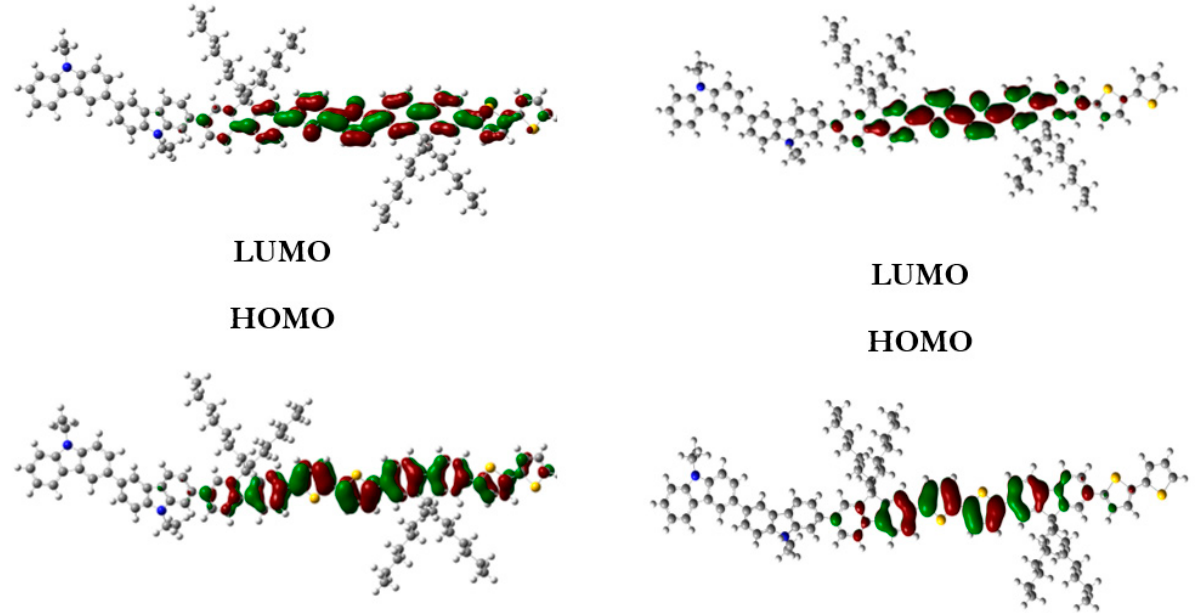
Figure 7. MO of the PVK-F8T2 in the ground and excited states.